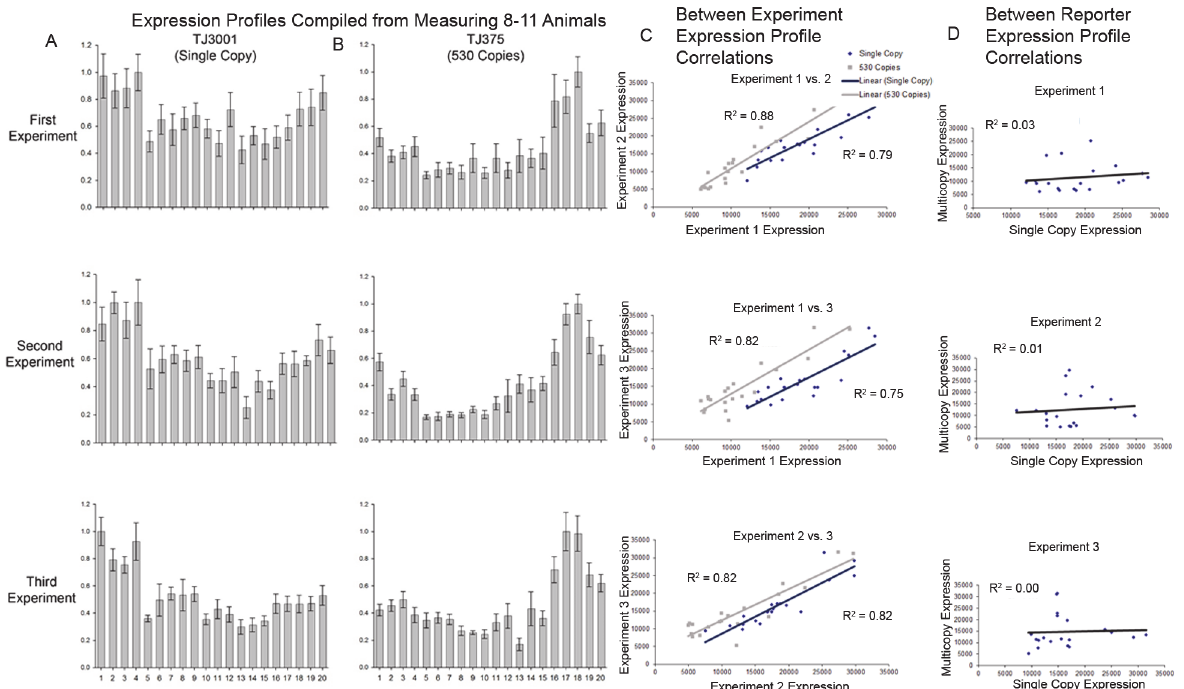
Fig 4. Consistency of experimental measurements. A & B) Single-cell expression profiles of different P hsp-16 . 2 - GFP reporters in the 20 cells of the intestine from three different experiments. The different intestinal cells are laid out anterior to posterior, and numbered 1 to 20. They correspond to the cell names and lineage relationships detailed in Figs 2 and S1. The heights of the bars show expression level normalized to the brightest cell for each reporter in each experiment. C) Consistency of cell-specific expression patterns within a strain. Consistency of expression profiles of P hsp-16 . 2 - GFP reporters in individual cells in TJ3001 (single copy) and TJ375 (530 copy) animals. Results come from three experiments on three different days. Plots show average expression for a given cell from one experiment as x, and average expression for the same cell measured in a different group of animals in a different experiment as y, for all combinations of two experiments. Expression profiles were between 75 and 88% correlated between experiments. D) Lack of similarity of cell-specific expression patterns between single copy and 530 copy strains. Average expression values for the single copy reporter were plotted as x, and the average expression value for the same cell in different animals expressing the multicopy reporter was plotted as y. Cell-specific expression from these two different P hsp-16 . 2 reporter strains is not